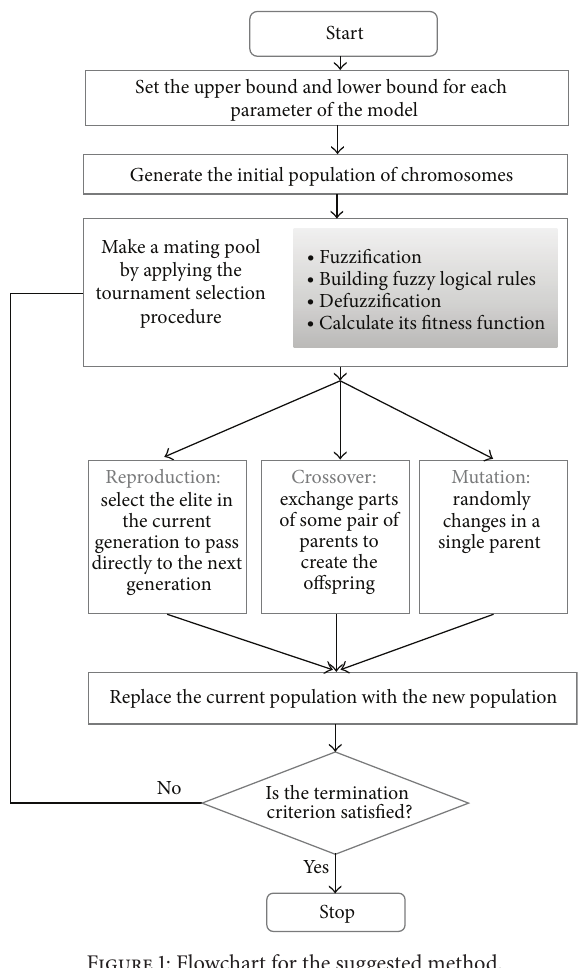
Figure 1: Flowchart for the suggested method.